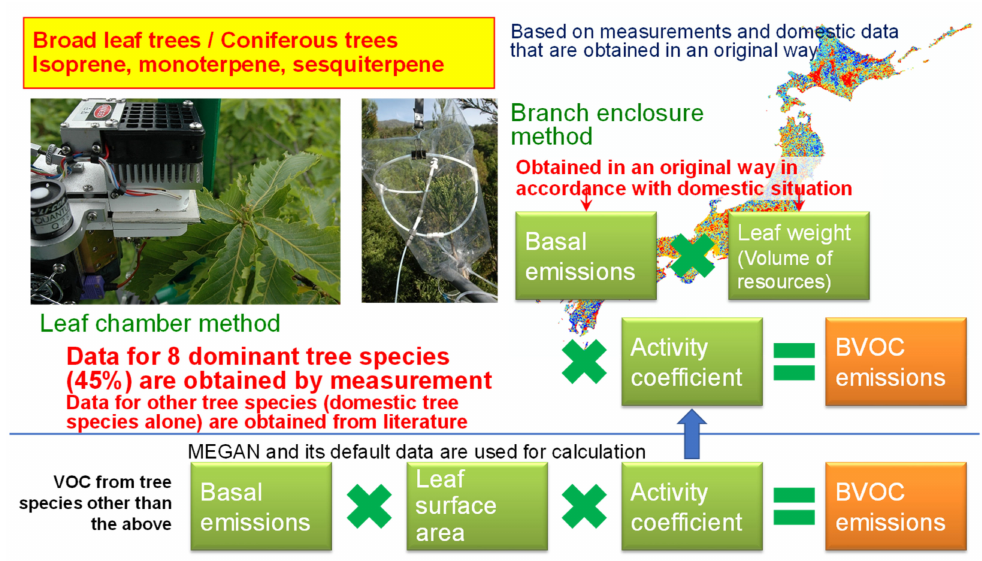
Figure 9. Overview of biogenic VOC inventory in